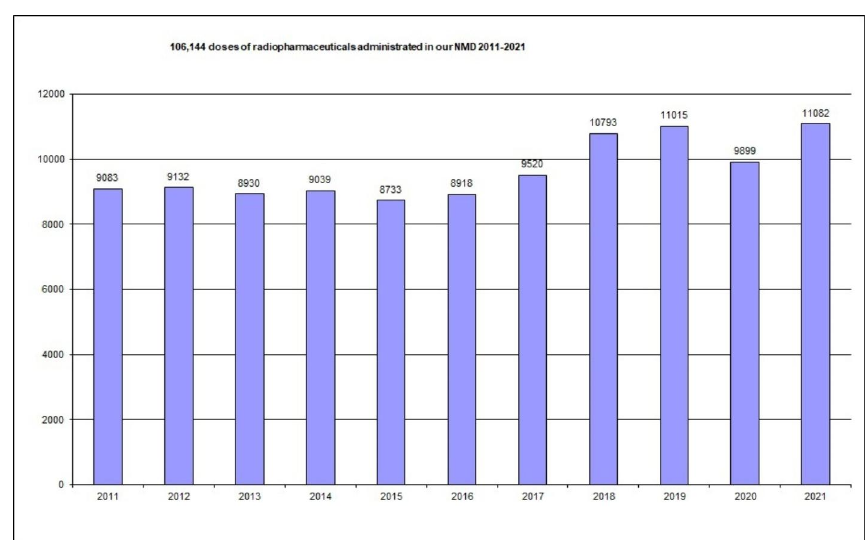
Fig. 2 Distribution of radiopharmaceutical doses administrated from 2011 to 2021